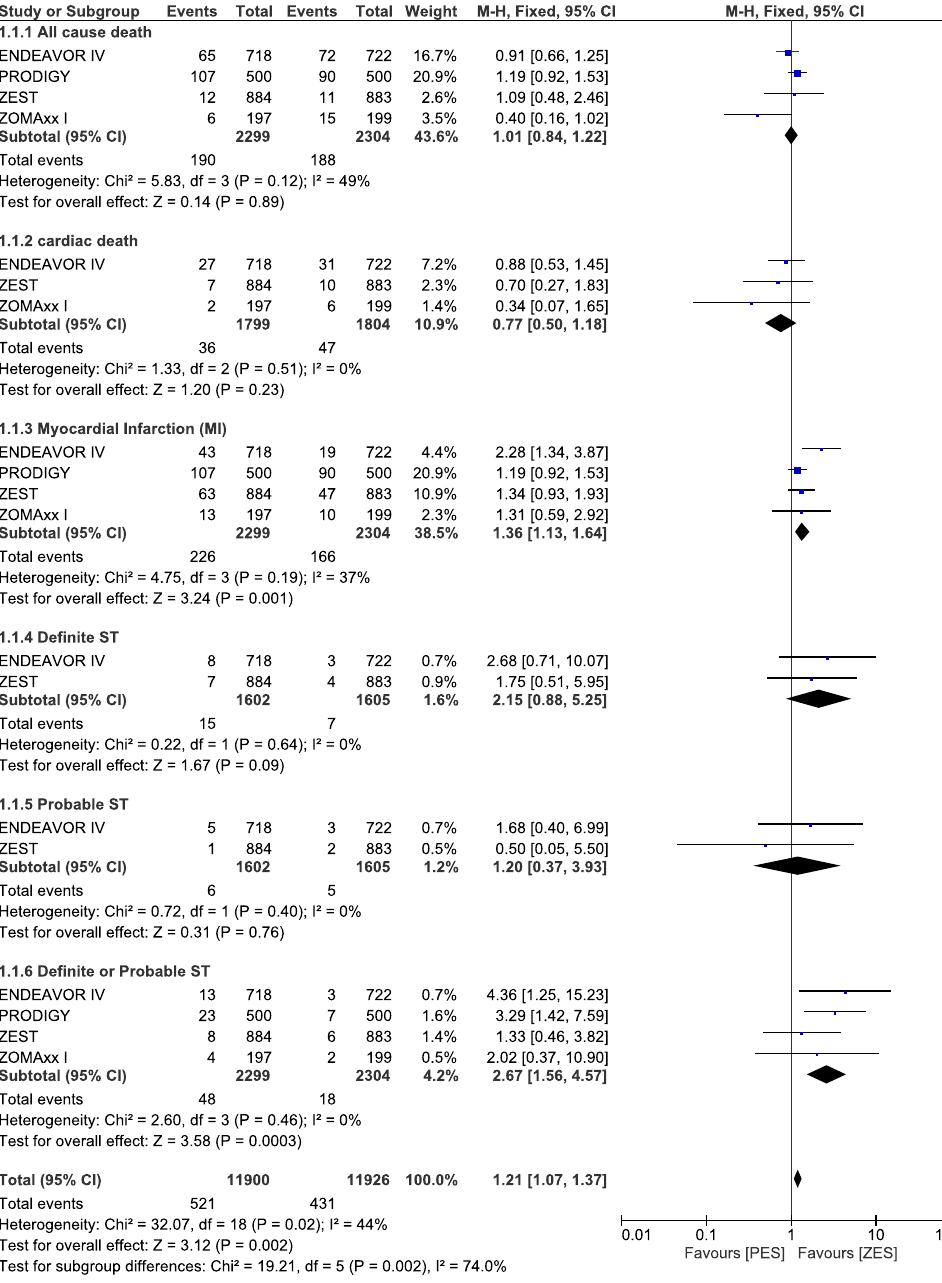
Figure 7. Long-term adverse clinical outcomes which were associated with ZES versus PES alone (part